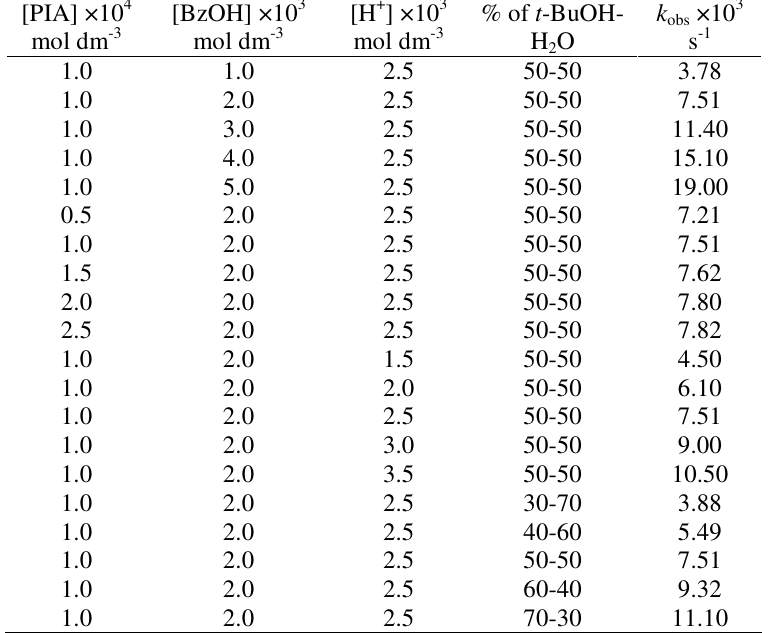
Table 1. Effect of varying [BzOH], [PIA], [H + ] and the solvent composition on the reaction rate temperature